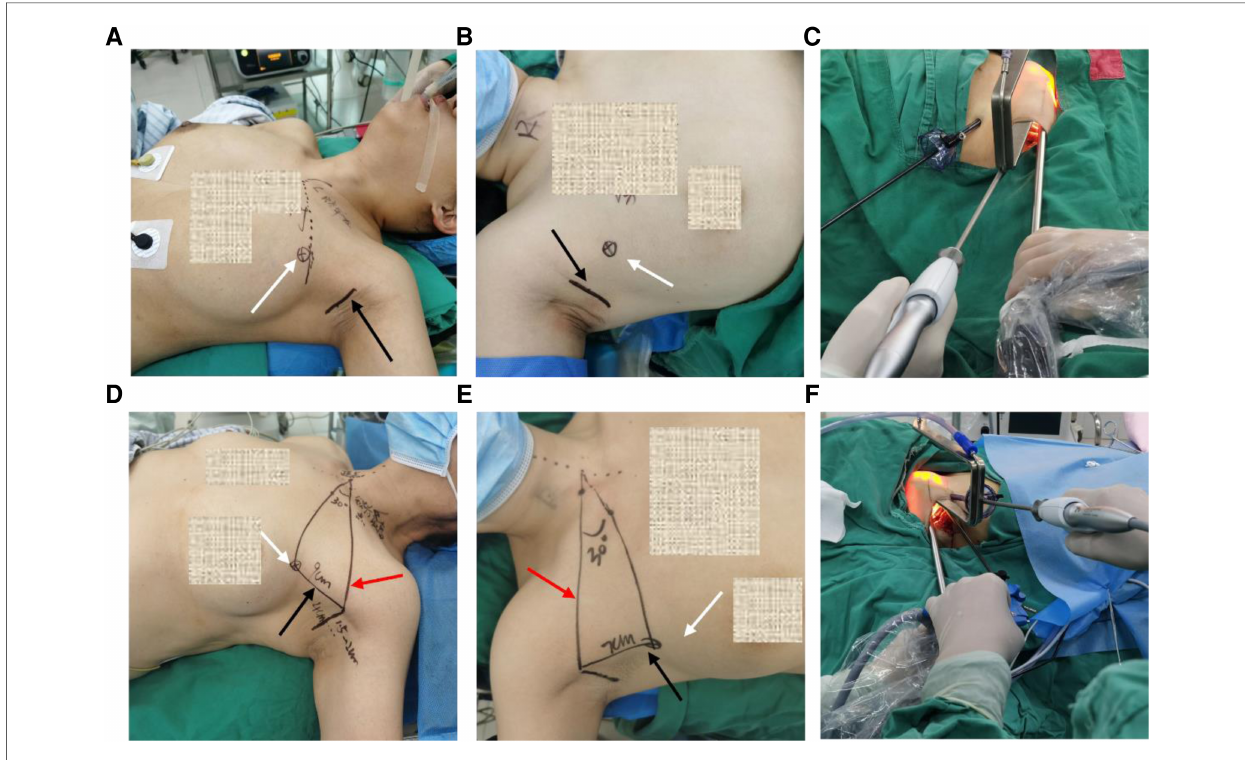
FIGURE 2 Representative photos of zero-line and classical incision design. ( A,B ) Classical designation on body surface for left-side and right-side thyroidectomy. ( C ) Endoscope, surgical clamp, and auxiliary clamp cooperation for left-sided thyroidectomy. ( D,E ) Zero-line designation on body surface for left-side and right-side thyroidectomy. ( F ) Endoscope, surgical clamp, and auxiliary clamp cooperation for right-sided thyroidectomy. Black row indicated the main incision, white row indicated the trocar incision, red row indicated the